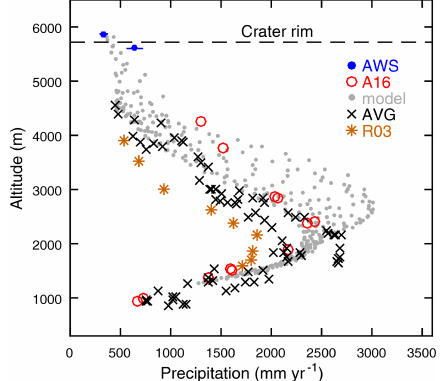
Figure 10. Mean annual precipitation or (AWS) accumulation ver- sus altitude at various locations in the southern mountain sec- tor from different sources: AWS data and all model grid cells on the southern slope for October 2009–September 2013; pub- lished values from Appelhans et al. (2016), A16 (2012–2014); Røhr and Killingtveit (2003), R03 (October 1999–September 2001); and again Appelhans et al. (2016), which constructed a longer-term av- erage (AVG) since 1997 from the network of Hemp (2006). The error bar for AWS data (Table 1) is hardly visible at that scale. Hor- izontal dashed line shows the approximate altitude of the crater